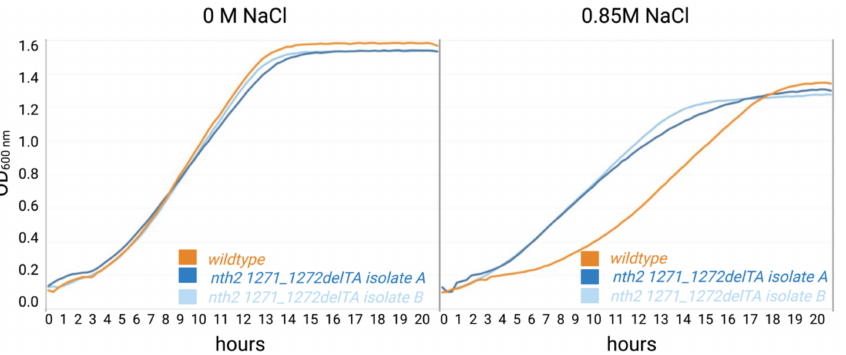
Figure 4. Growth curves of S. cerevisiae nth2 1271_1272delTA strains in the presence and absence of osmotic stress (0.85 M NaCl) by indirect measurements of optical density at 600 nm after 20 h of growth under stress. The curve was built with the mean of four independent samples per hour for each condition. The growth rate was calculated for the wild type in non-stress conditions of 0.2255 ± 0.0037 h − 1 versus 0.1580 ± 0.0009 h − 1 in 0.85 M NaCl stress, and nth2 1271_1272delTA